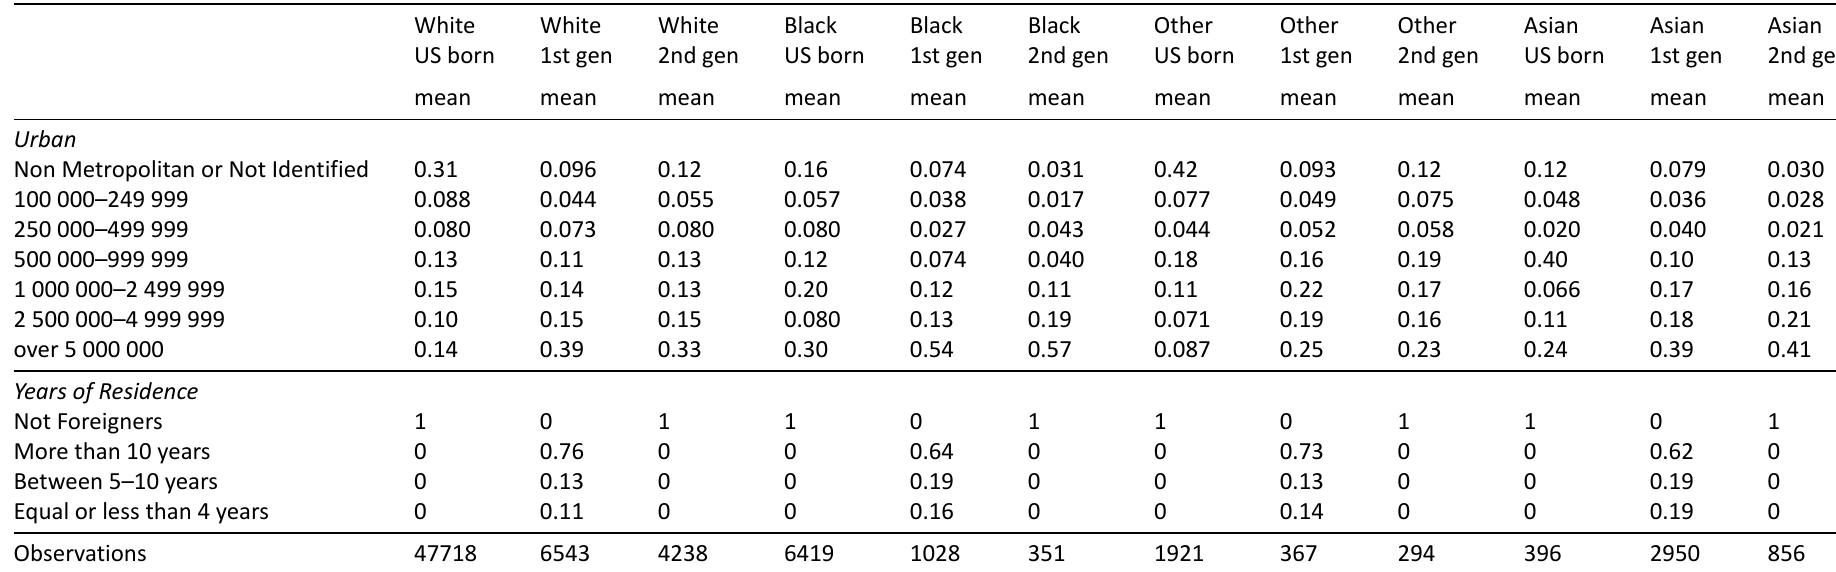
Table 1. (Cont.) Descriptive statistics by ethnicity and migrant status.